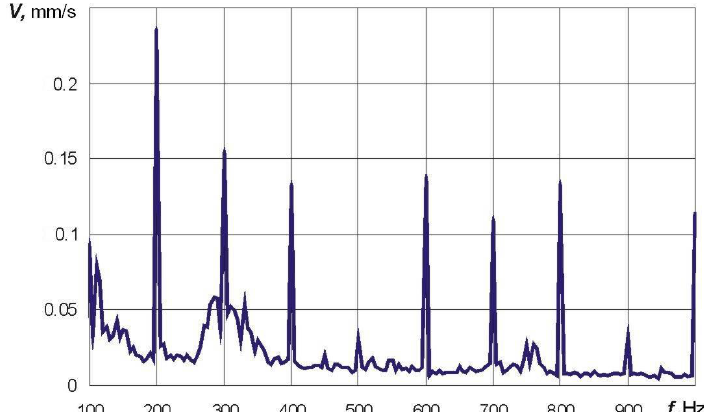
Figure 9. Graph of the averaged over the sample surface vibration rate as a function of the sample vibration frequency during laser irradiation at a frequency of 100 Hz [38].